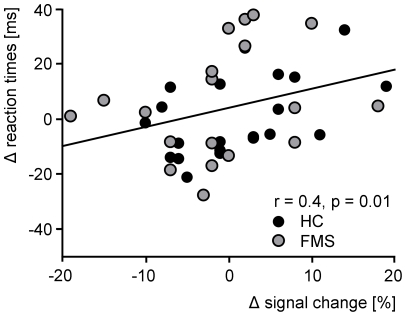
Relationship between pain-induced changes in visual gamma oscillations and pain-induced changes in visual task performance.Displayed is the correlation between the signal change of visual gamma oscillations (signal changeno pain – signal changepain) at occipital electrodes, and the change of reaction times after painful laser stimulation (RTpain – RTno pain). Stronger pain-related modulations of visual gamma oscillations are associated with stronger pain-related modulations of reaction times.